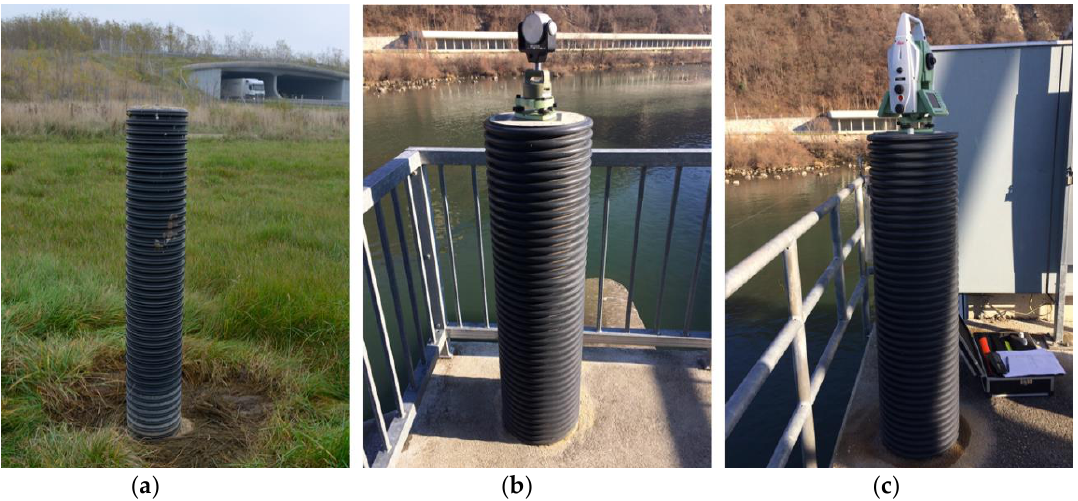
Figure 1. Examples ( a – c ) of inappropriately chosen reference points; the pillars are thin and wrapped in black PVC tubes.